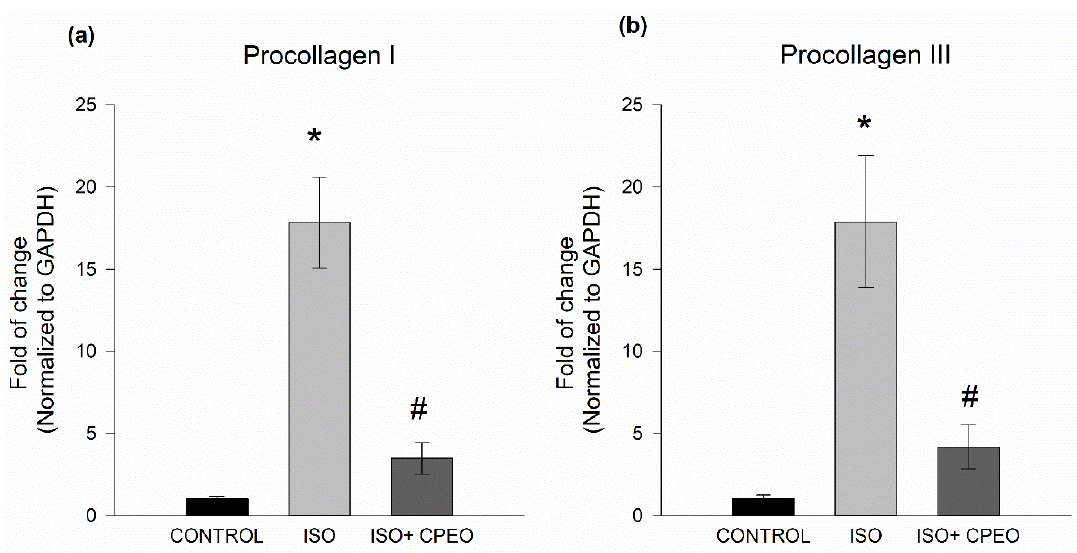
Figure 5. Effect of Cymbopogon proximus essential oil (CPEO) and/or isoproterenol (ISO) on levels of fibrosis markers. Male albino rats were injected intraperitoneally daily with vehicle, CPEO (800 µ L / kg / d), ISO (5 mg / kg), or CPEO (800 µ L / kg / d) plus ISO (5 mg / kg). Oil administration was started four days prior to ISO administration and continued concurrently thereafter for an additional 3 d. Gene expression levels of fibrosis markers Pro I ( a ) and Pro III ( b ) were determined in the heart using quantitative real-time polymerase chain reaction. The results are presented as the means of six independent experiments ± SEM. * p < 0.05 compared to control, # p < 0.05 compared to ISO-treated